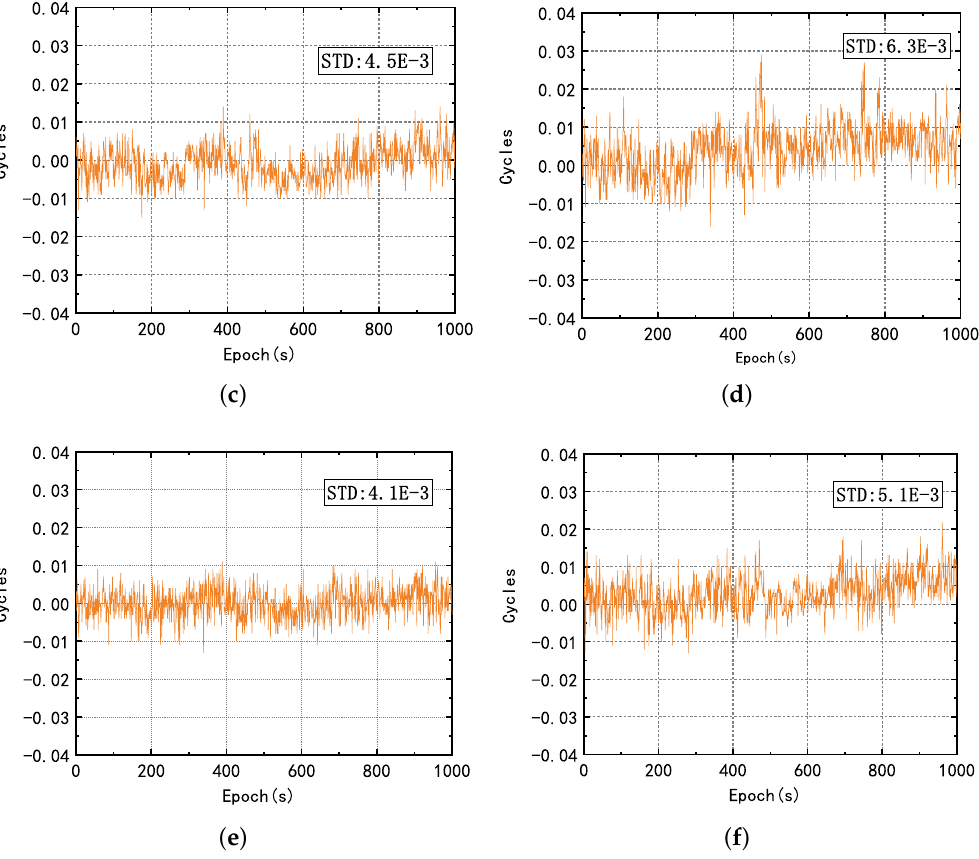
Figure 4. Single-difference carrier phase values between S1 and other pseudolites: ( a ) pseudolite 1 with pseudolite 2; ( b ) pseudolite 1 with pseudolite 3; ( c ) pseudolite 1 with pseudolite 4; ( d ) pseudolite 1 with pseudolite 5; ( e ) pseudolite 1 with pseudolite 6; ( f ) pseudolite 1 with pseudolite